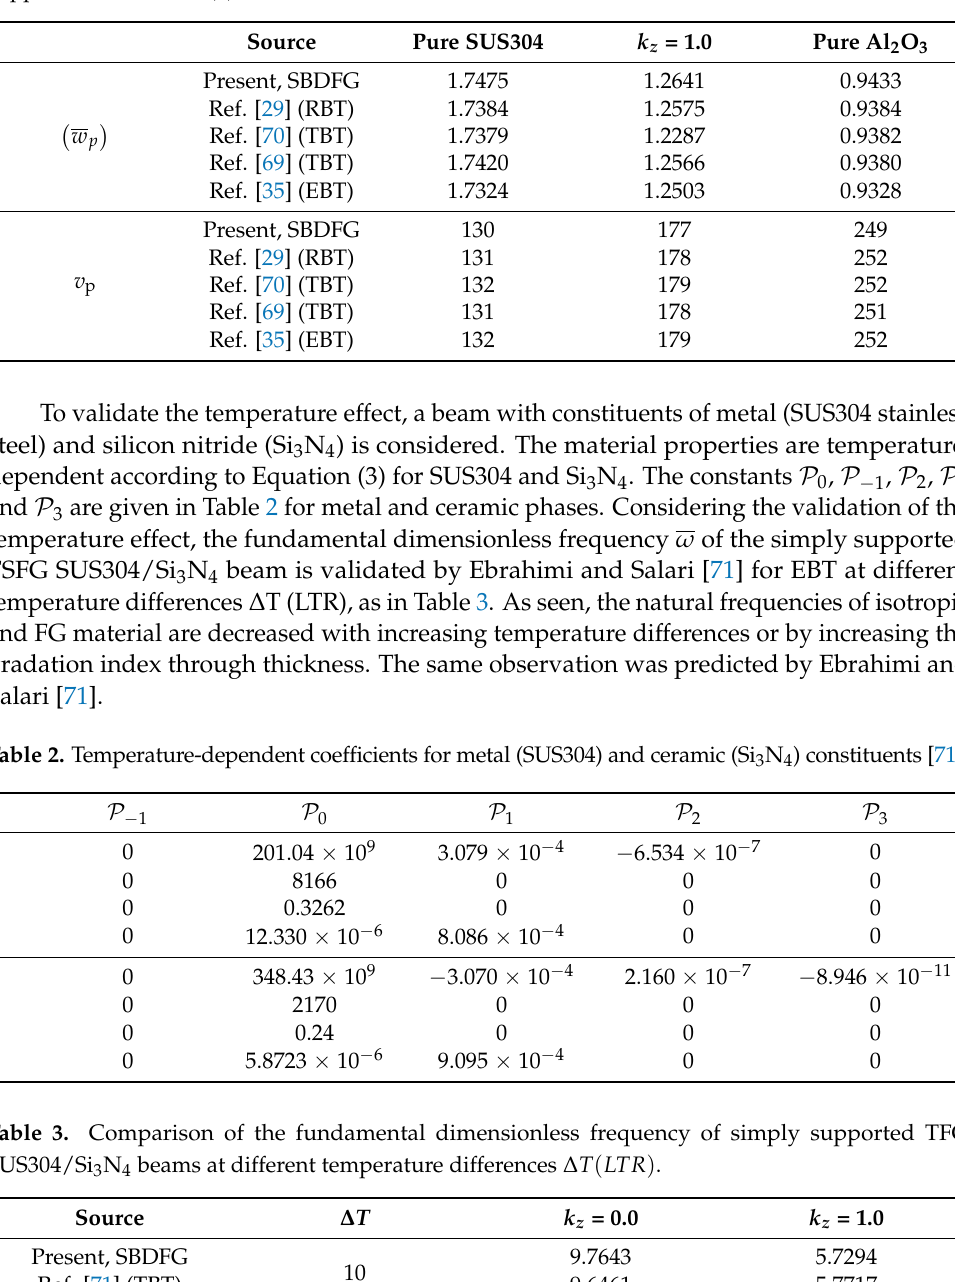
(cid:0) (cid:1) w p and corresponding absolute velocity v p of simply